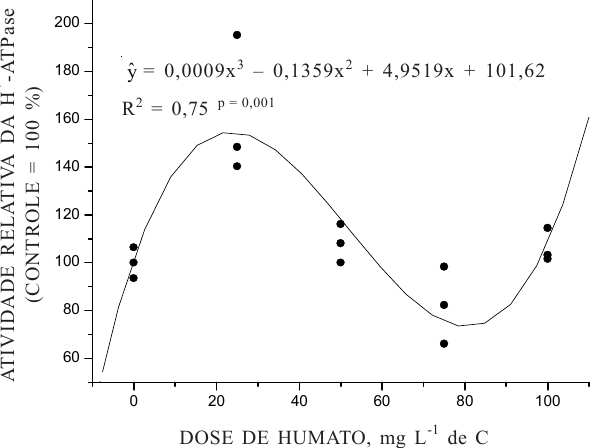
Figura 3. Estímulo da atividade vanadato-sensível de hidrólise de ATP da fração microssomal extraída de raízes de plântulas de